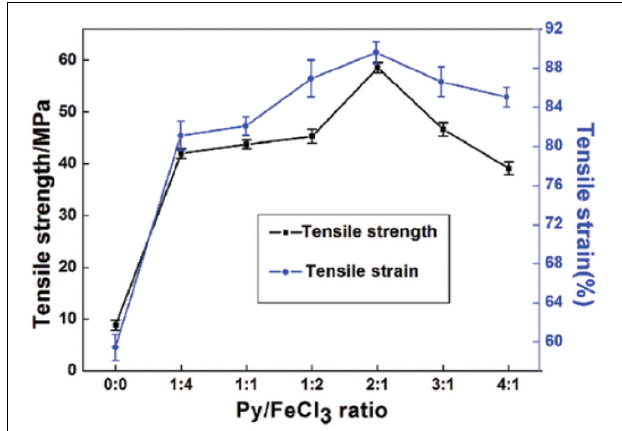
FIGURE 1 | Tensile properties of raw cotton (warp) and PPy/cotton composites with different Py/FeCl3 ratios. Reproduced from Xie et al. (2019) under the Creative Commons CC-BY